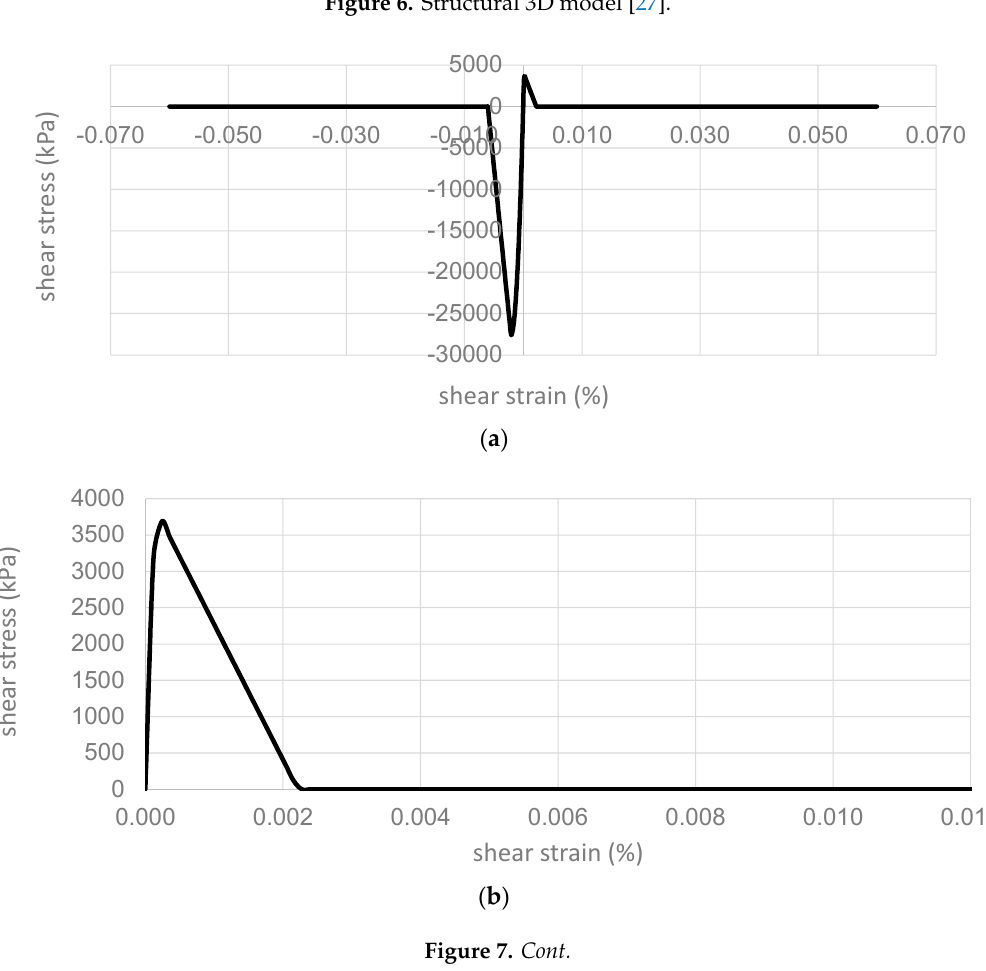
Figure 6. Structural 3D model [27].